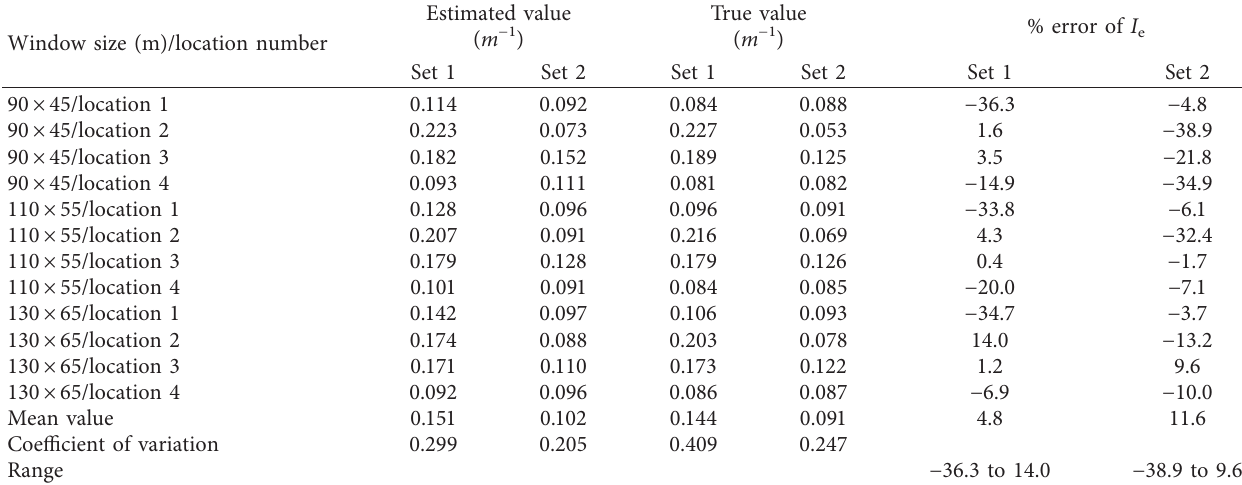
Table 1: Estimated intensity and its % error based on rectangular sampling windows.